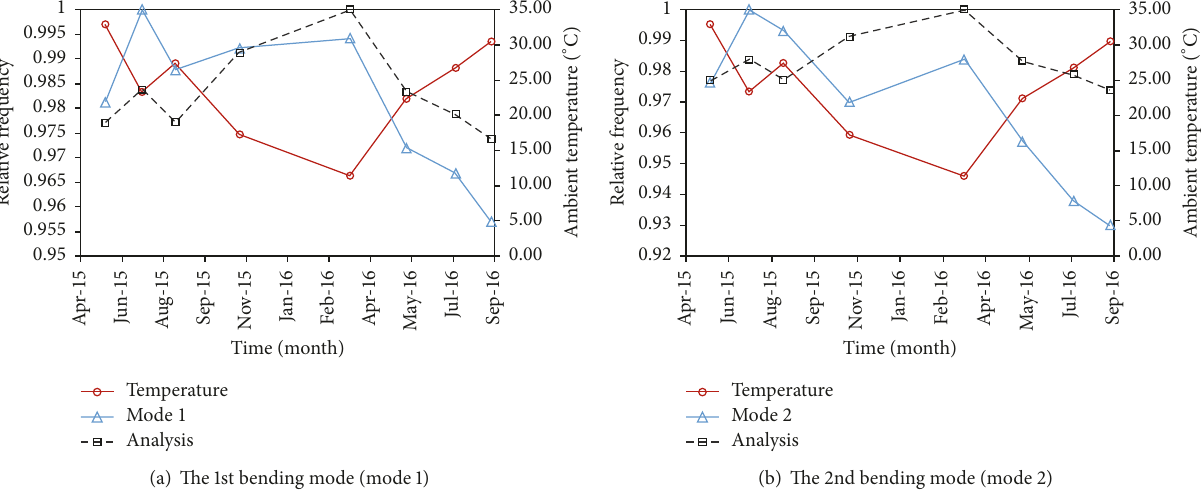
and both side surfaces of girders No. 1 and No. 2 whereas girder No. 3 suffered only a few. In addition, it is difficult to estimate the higher order modes with precise